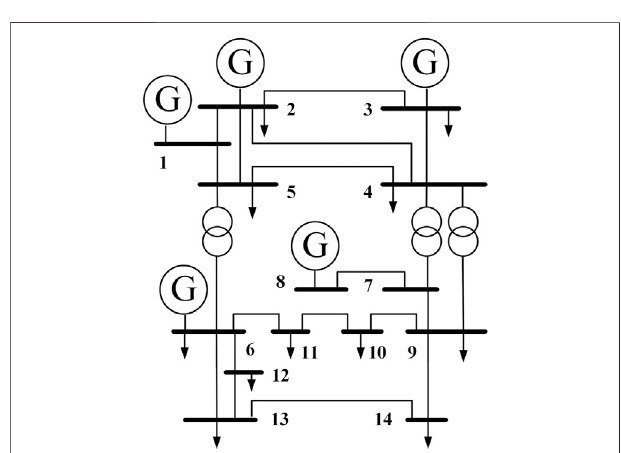
FIGURE 4 | IEEE14-bus system network